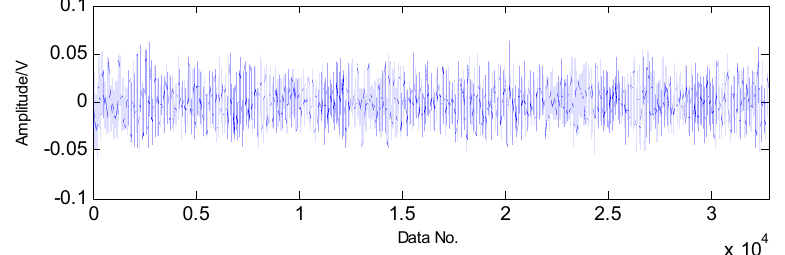
Figure 27. Original vibration signals collected from healthy roller bearing.